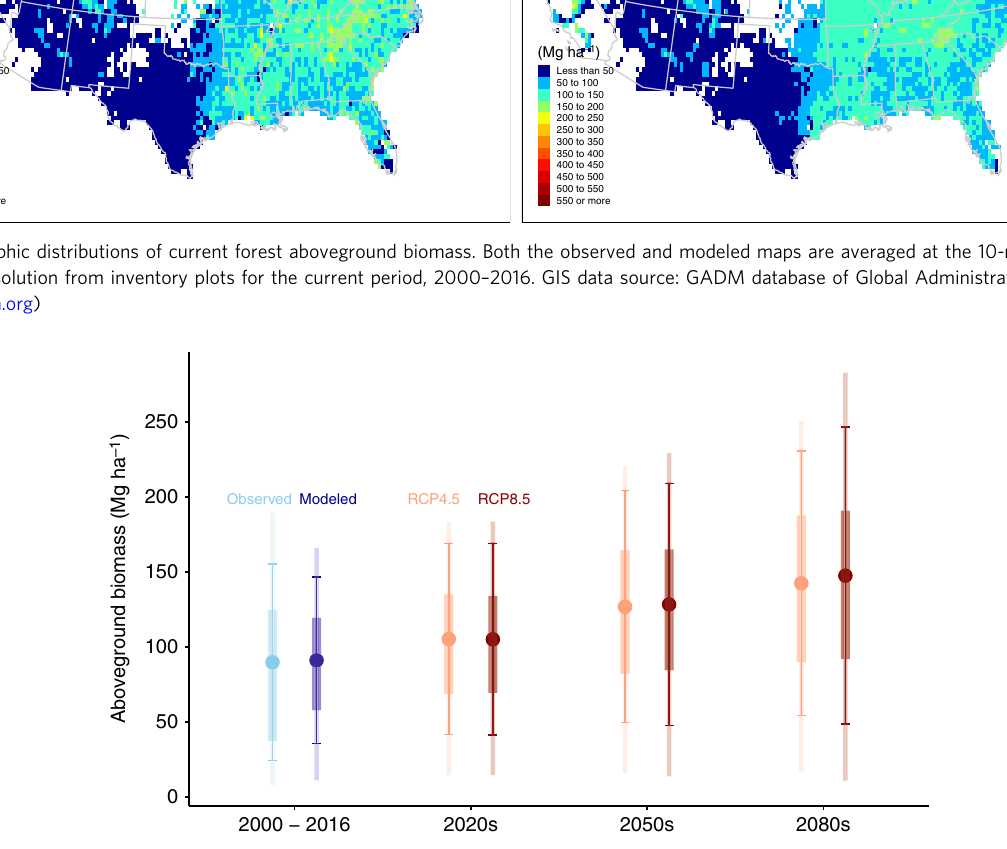
Fig. 3 Trends of the current and future forest aboveground biomass. The current period (2000 – 2016) is summarized as observed and modeled values. The future periods (2020s, 2050s, 2080s) are summarized as two IPCC scenarios (RCP4.5 and RCP8.5) under the best-case circumstances of no disturbances. Points are means, error bars are standard deviations, thick lines are 50% quantiles (25% and 75%), and thin lines are 90% quantiles